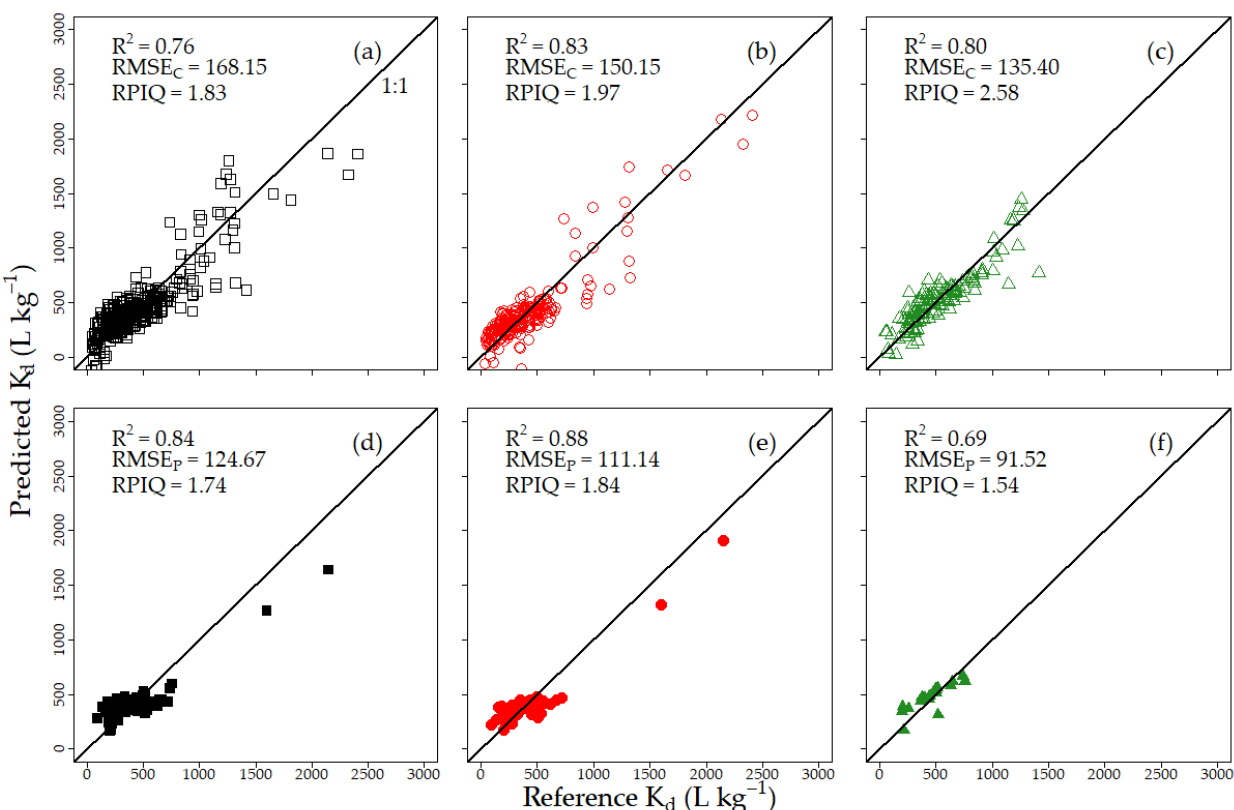
Figure 5. Pedotransfer functions for the estimation of the K d of glyphosate. Results showing the calibration and validation subsets of the combined (( a , d ), respectively), Danish (( b , e ), respectively), and Greenlandic datasets (( c , f ), respectively). R 2 , coefficient of determination; RMSE C , root mean square error for calibration; RMSE P , root mean square error for prediction; RPIQ, ratio of performance to interquartile range.